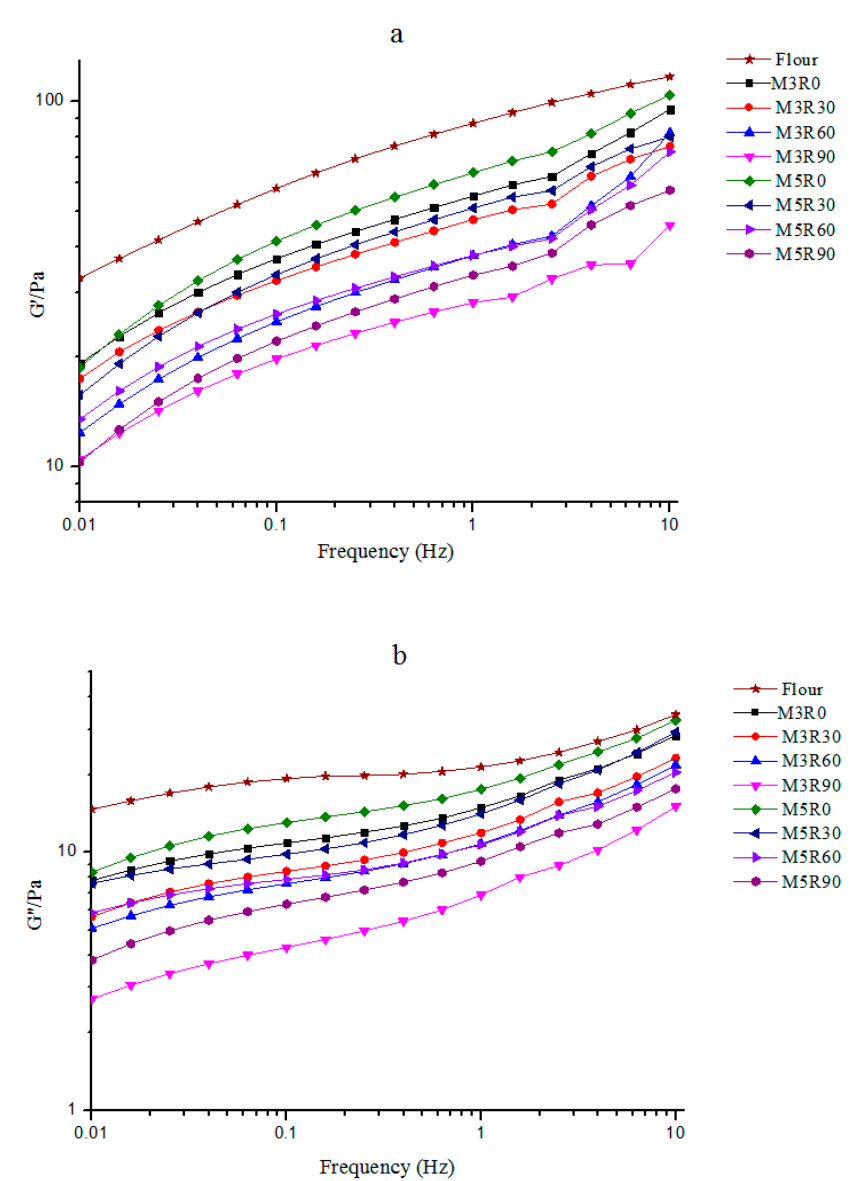
Figure 2. Changes in viscoelastic modulus G ′ ( a ) and G ′′ ( b ) for the GMP. Flour: wheat flour with- out mixing or resting. M3R0–M3R90: mixing for 3 min and resting for 0, 30, 60, and 90 min, respec- tively. M5R0–M5R90: mixing for 5 min and resting for 0, 30, 60, and 90 min, respectively.